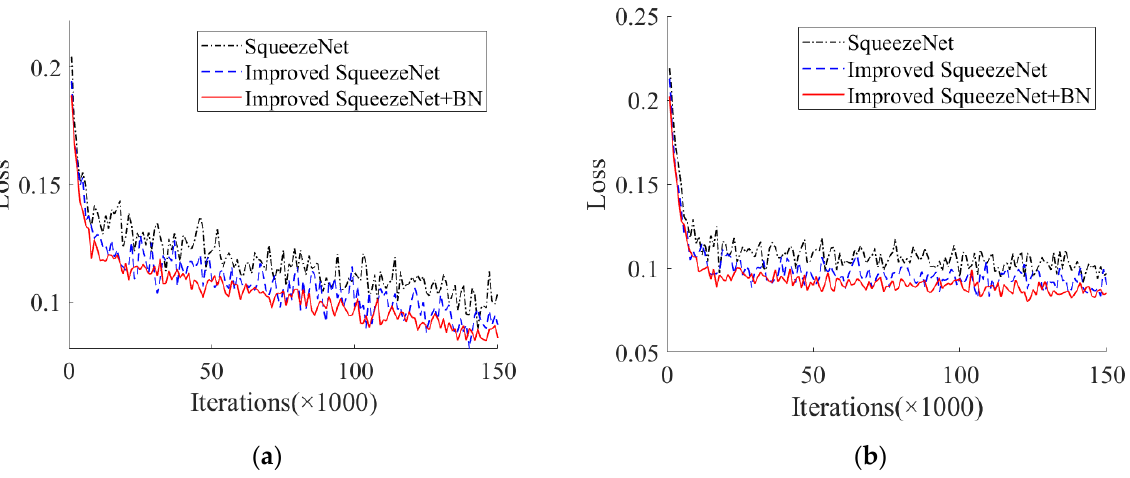
Figure 12. The loss function curves of different SqueezeNet models: ( a ) classification loss of fully connected layer; ( b ) regression loss of the fully connected layer.